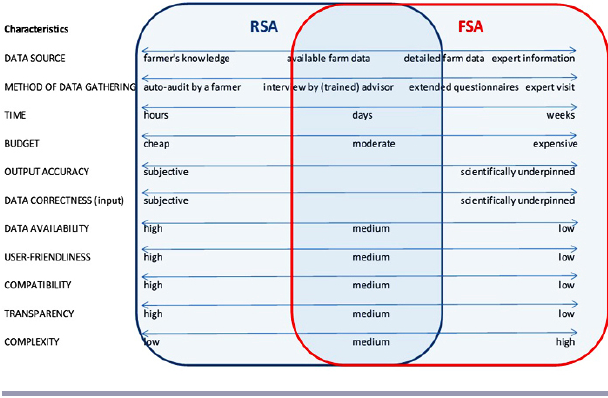
Fig. 3 . Characteristics describing full sustainability assessment (FSA) and rapid sustainability assessment (RSA)